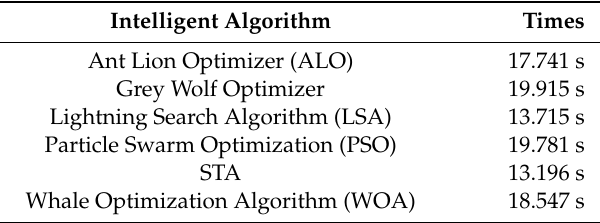
Table 1. The intelligent algorithm optimization time.